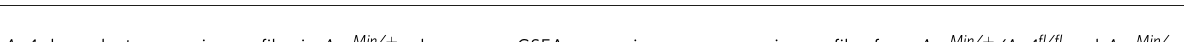
Fig. 4 Ap4- dependent expression pro fi les in Apc Min/ + adenomas. a GSEA comparing gene expression pro fi les from Apc Min/ + /Ap4 fl / fl and Apc Min/ + /Ap4 Δ IEC adenomas from 120 days old mice with Lgr5-positive stem cell signatures 13 , Wnt/ β -catenin signaling (mSigDB: molecular Signatures Database), Notch target genes or c-Myc target genes (mSigDB). NES: normalized enrichment score, Nom. p -value: nominal p -value. b Heatmap of selected differentially expressed mRNAs ( p -value < 0.05) from intestinal stem cell gene signatures, Wnt/ β -catenin signaling and/or Notch signaling gene signatures analyzed in a . The heatmap displays relative fold changes in expression levels normalized to the mean expression in the control, Apc Min/ + /Ap4 fl / fl , samples for each indicated mRNA. Three biological replicates per genotype were analyzed. c qPCR analysis of the indicated mRNA derived from tumors from three female mice ( fi ve tumors per mouse) per genotype. d The murine CRC cells CT26 were subjected to qChIP analysis with Ap4 or IgG- speci fi c antibodies for ChIP. The mouse acetylcholine receptor ( AchR ) promoter, which lacks Ap4-binding motifs, served as a negative control. E-boxes used for qChIP analysis are marked in Supplementary Fig. 3. c , d Results represent the mean ± SD. Results were subjected to an unpaired, two-tailed Student ’ s t - test with p -values * < 0.05, ** < 0.01, *** < 0.001, n.s.: not signi fi cant. See also Supplementary Fig. 3, Supplementary Data 1 and Supplementary Data